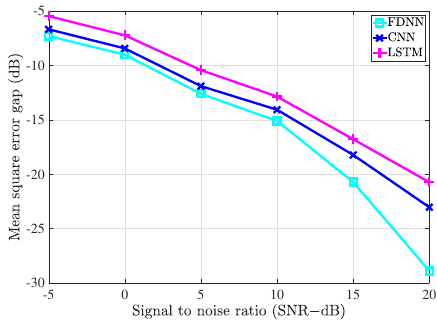
Figure 12. The MSE gap (dB) between the deep learning-based channel estimation methods and the LMMSE estimation with f D = 200